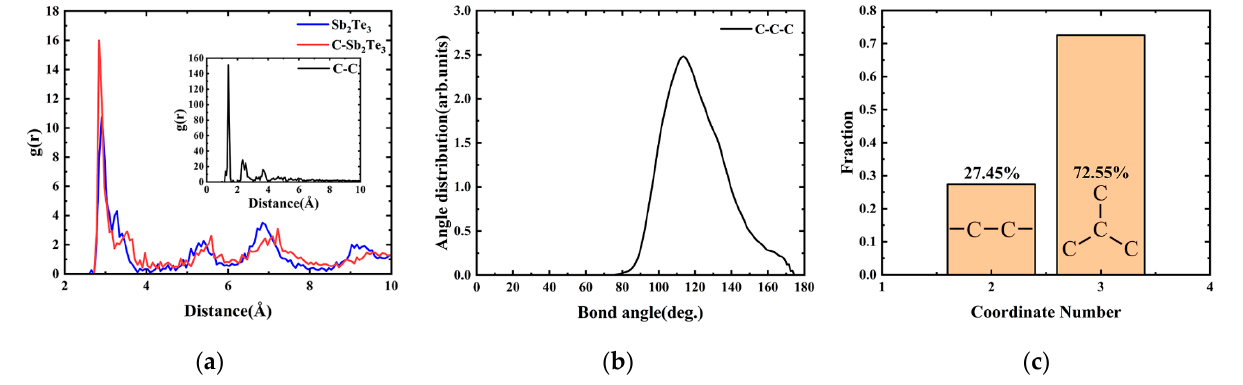
Figure 8. ( a ) Pair correlation function (PCF) of the Sb-Te bond and the C-C bond in crystal Sb 2 Te 3 and C-Sb 2 Te 3 after structural relaxation; ( b ) bond angle distribution of the C-C-C configuration; and ( c ) coordination number statistics of C